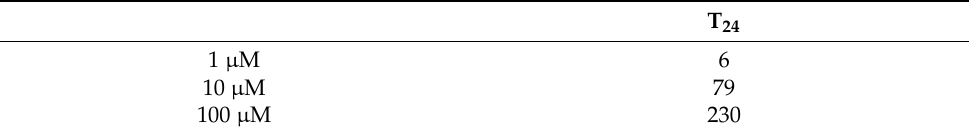
Table 2. Values of the bioaccumulation ratio to control values after 24 months from